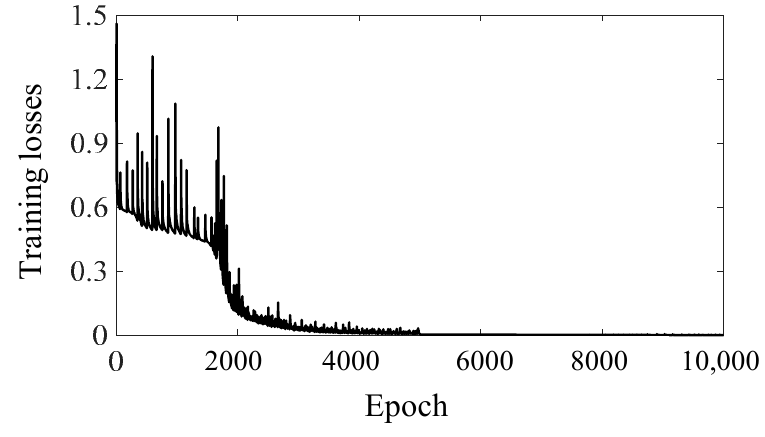
Figure 4. Training loss versus epoch.